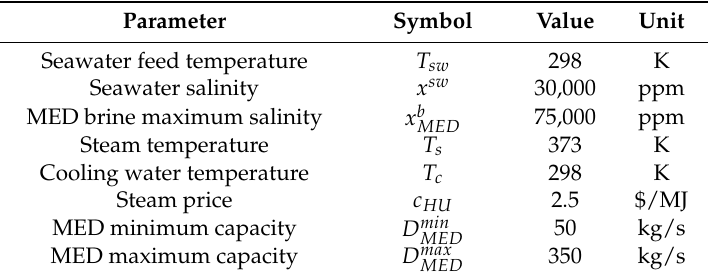
Table 1. Design basis for the case study.